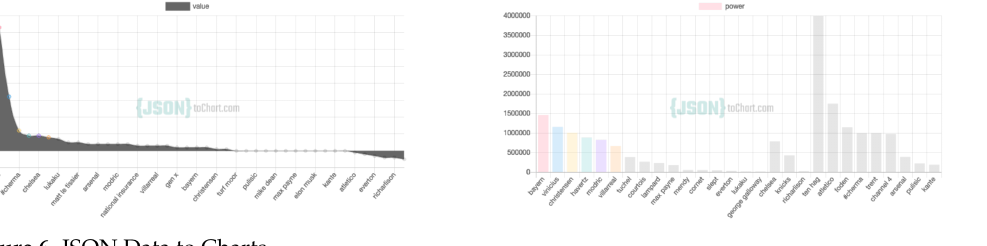
Figure 6. JSON Data to